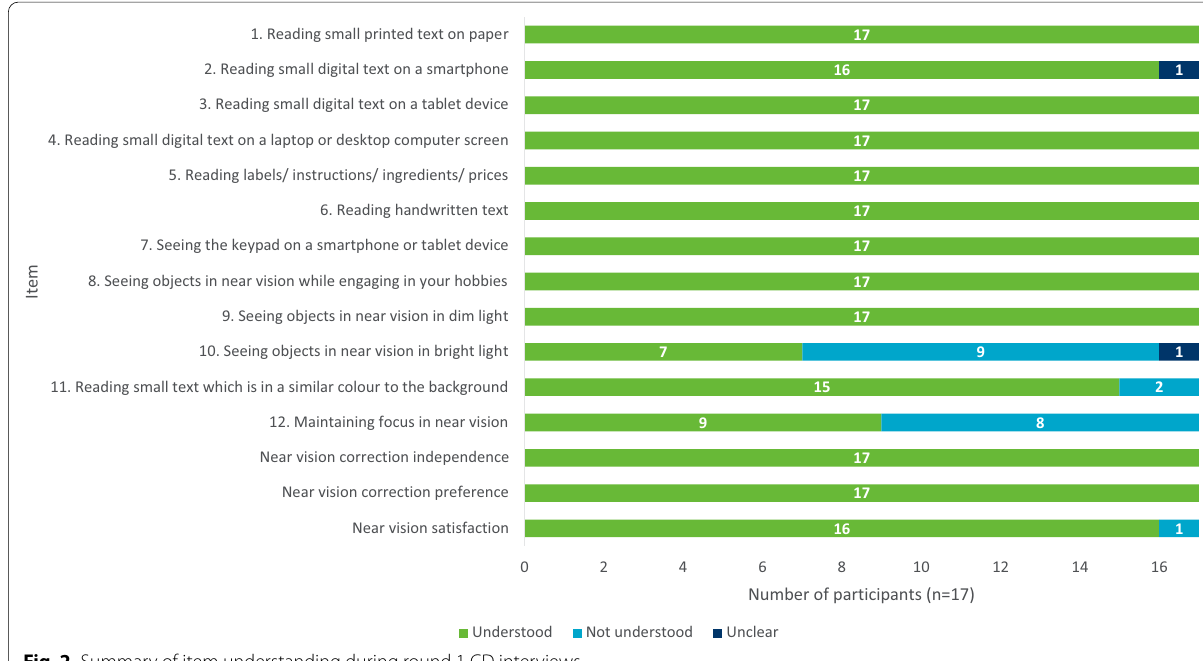
Fig. 2 Summary of item understanding during round 1 CD